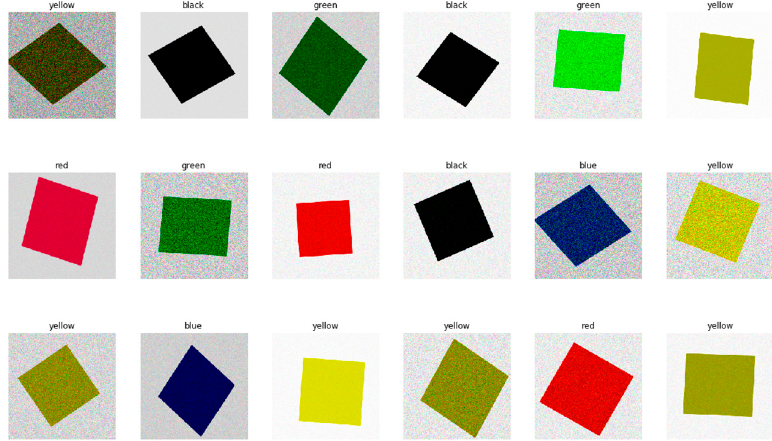
Figure 3. Training base. Samples produced using TensorFlow library.